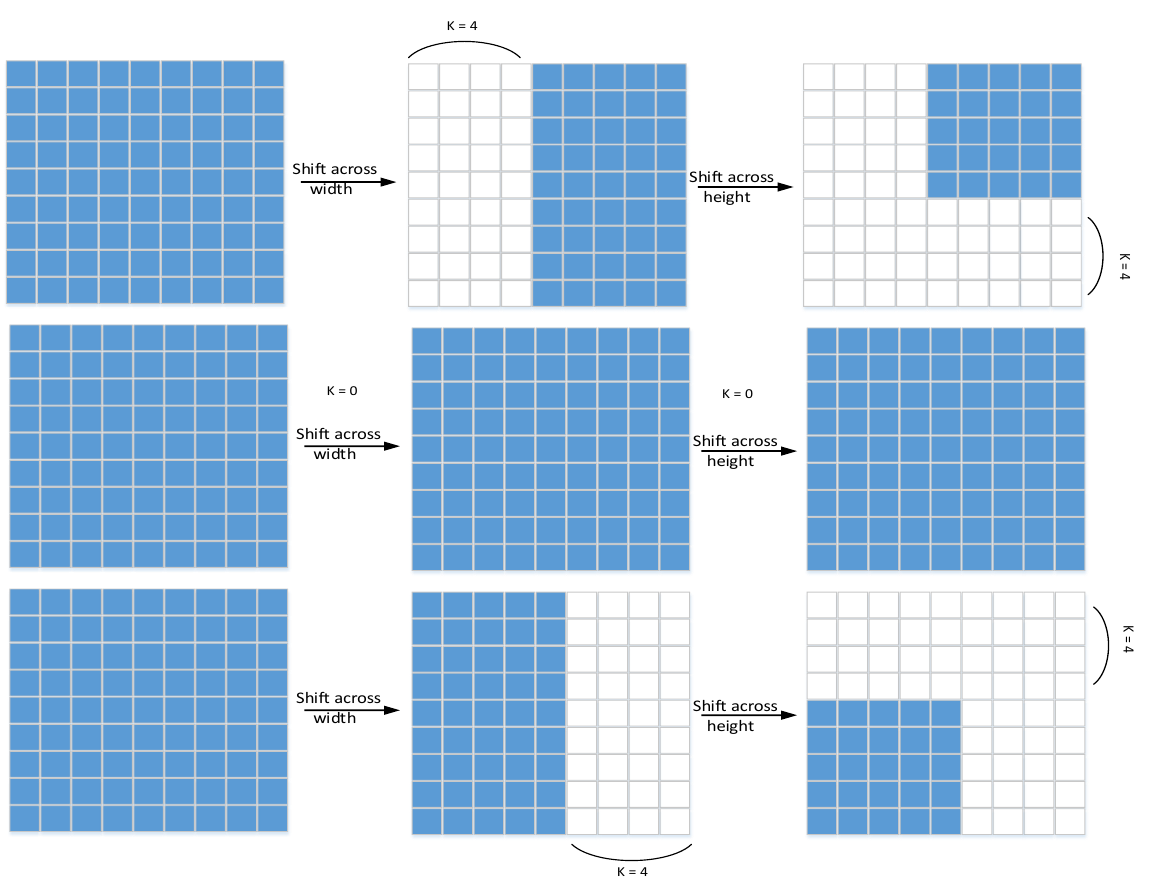
Figure 2. Shift operation schematic diagram. Features move in order in height and width. White is the padding after the move, and blue is the position of the feature block.